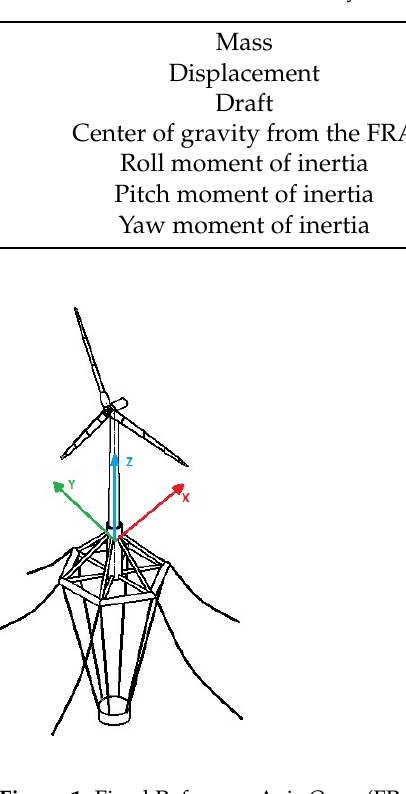
Figure 1. Fixed Reference Axis Oxyz